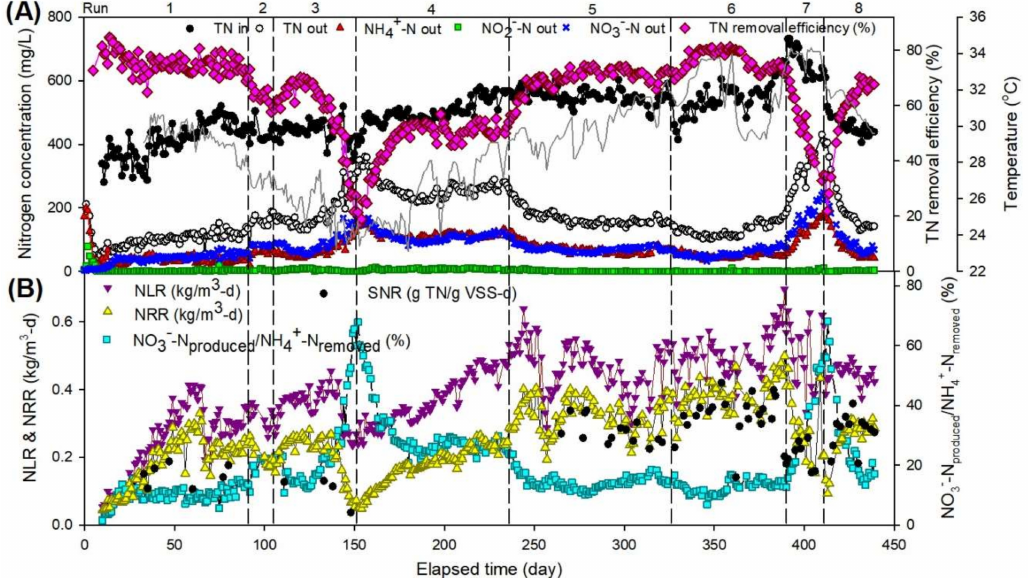
Figure 2. Treatment performance of the anammox process during long-term operation: ( A ) Changes in TN, NH 4 + -N, NO 2 − -N, and NO 3 − -N concentrations, TN removal efficiency, and temperature ( B ) Changes in NLR, NRR, SNR, and the ratio of produced NO 3 − -N concentration to removed NH 4 + -N